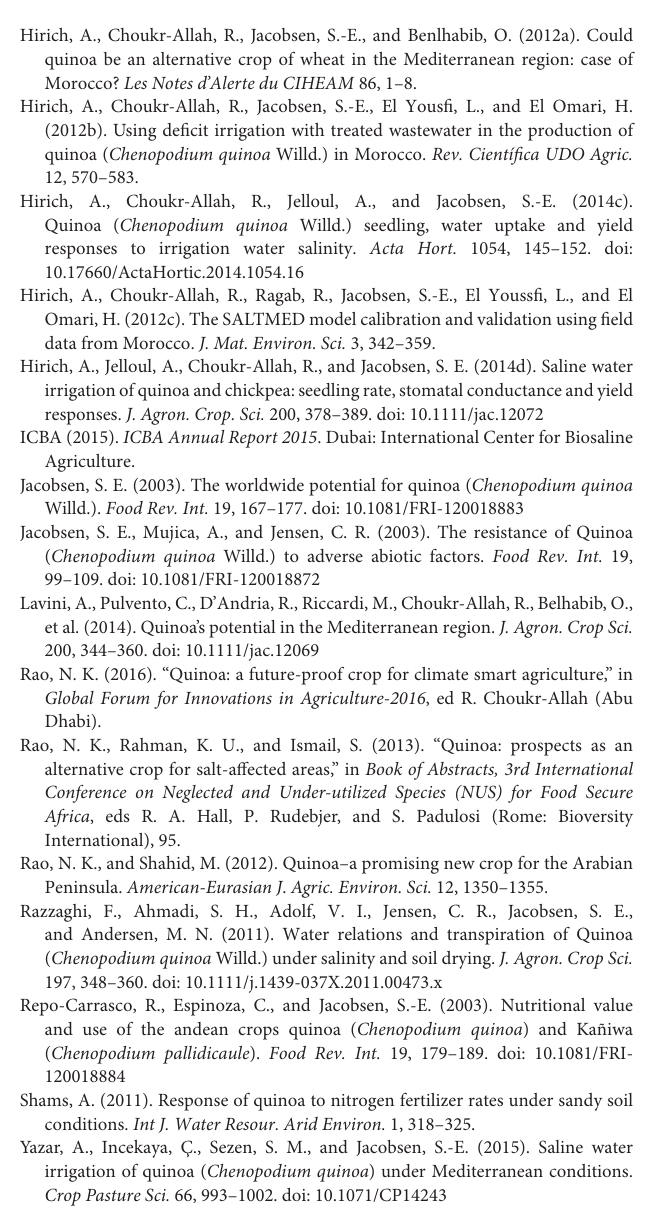
Supplementary Figure 5 | Field trial about responses of seven quinoa accessions to several irrigation levels. Supplementary Figure 6 | Genetic and morphological variability of several quinoa